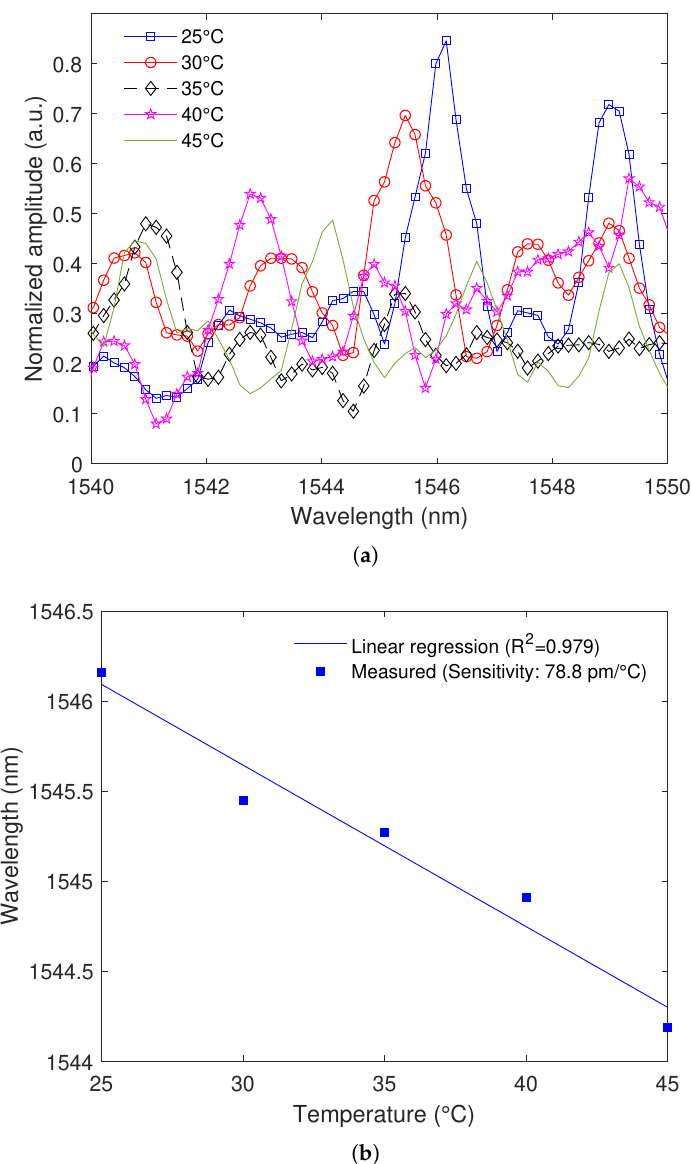
Figure 8. ( a ) Transmitted spectra as a function of the temperature; ( b ) Wavelength variation as a function of